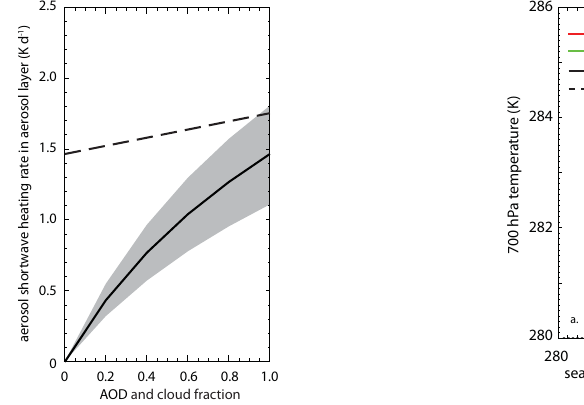
Fig. 3. Atmospheric shortwave heating rate averaged over the sim- ulated smoke layer (1700–4300m). Heating rate vs. AOD for cloud- free conditions indicated by the solid line and the dashed line shows the heating rate for AOD=1.0 vs. fraction of cloud cover beneath the smoke layer. Gray region shows range of heating rate for single- scattering albedo 0.89 ± 0.03.